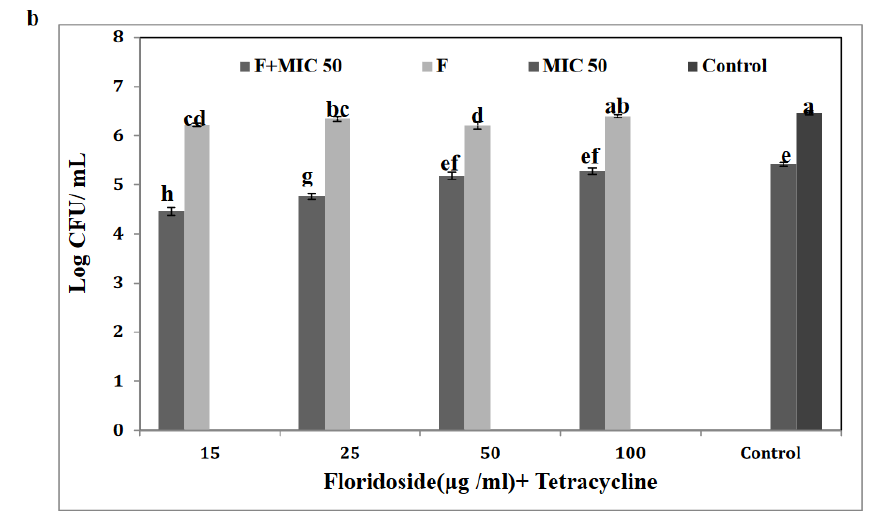
Figure 3. Combined effects of floridoside and tetracycline on the growth of S. Enteritidis. ( a ) MIC 25 ( b ) MIC 50 . Values with different superscript letters were significantly different ( p < 0.05). Values represented mean ± standard deviation from three independent experiments ( n = 9). F + MIC25: combination of floridoside and tetracycline at MIC 25 ; F: floridoside; MIC 25: tetracycline at MIC 25 ; F + MIC50: combinations of floridoside and tetracycline at MIC 50 . MIC 50: tetracycline at MIC 50 .